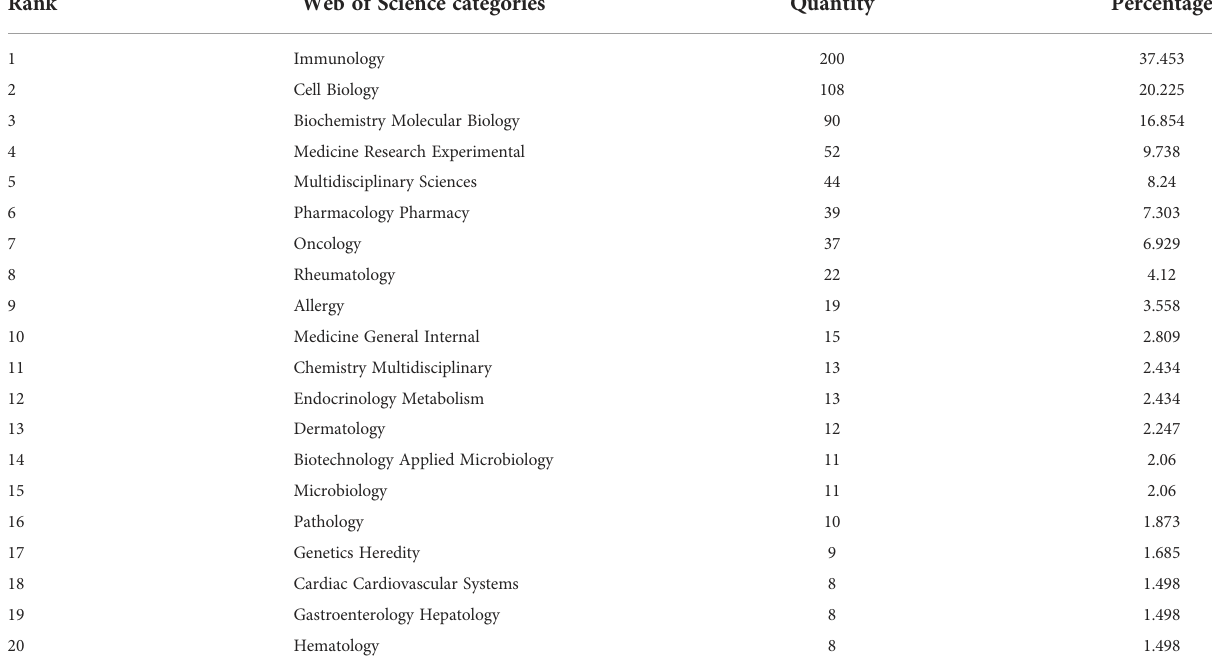
TABLE 7 Top 20 subject categories of IL-37 research.